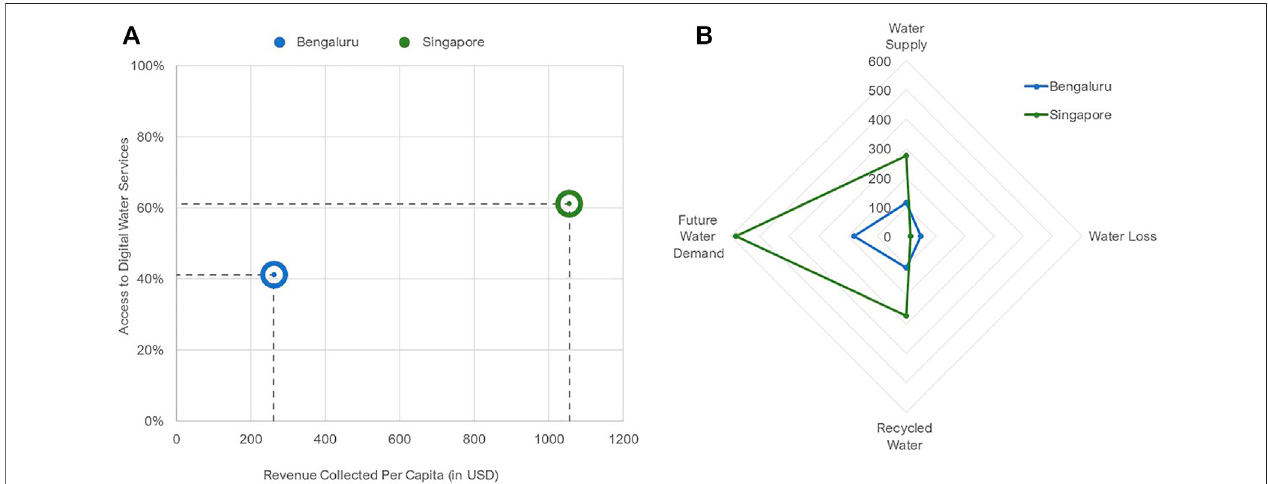
FIGURE2| The fi gureshowsacomparisonofthecurrentsituationinBengaluruandSingapore. Part (A) showstheaccesstodigitalwaterservicesinthetwocities plotted versus the revenue collected per person per year by the water utilities. Part (B) shows how the quantities of water supply, water loss, water recycled, and future waterdemandscompareacrossthetwocities.Theunitofthequantitiesinpart(b)areinliterpercapitaperday.Allthedatahasbeensourcedfromtheof fi cialwebsitesof the water utilities (JICA, 2017; Cag, 2018; Tortajada 2019).